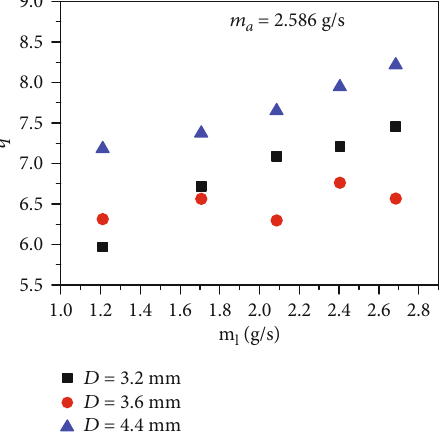
Figure 14: The drop size distribution parameter q of D series nozzle with various mass fl ow rates of fuel at air mass fl ow rate of ma = 2 : 586